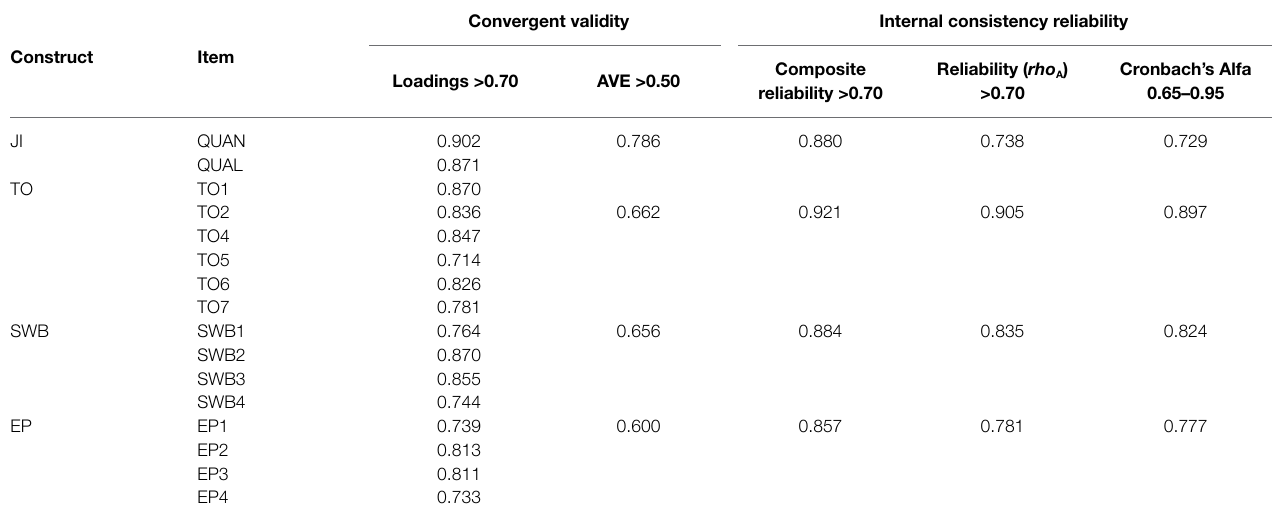
TABLE 2 | Convergent validity and internal consistency